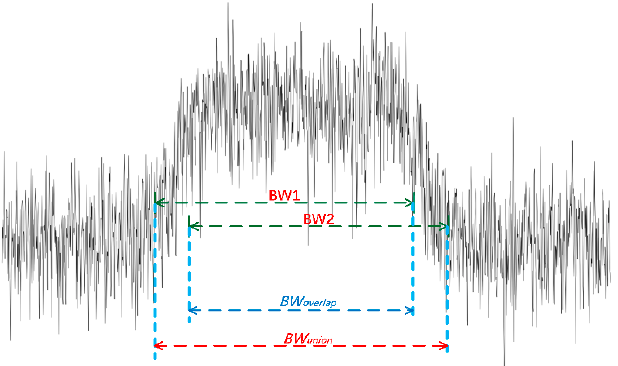
Figure 5. The carrier IoU.